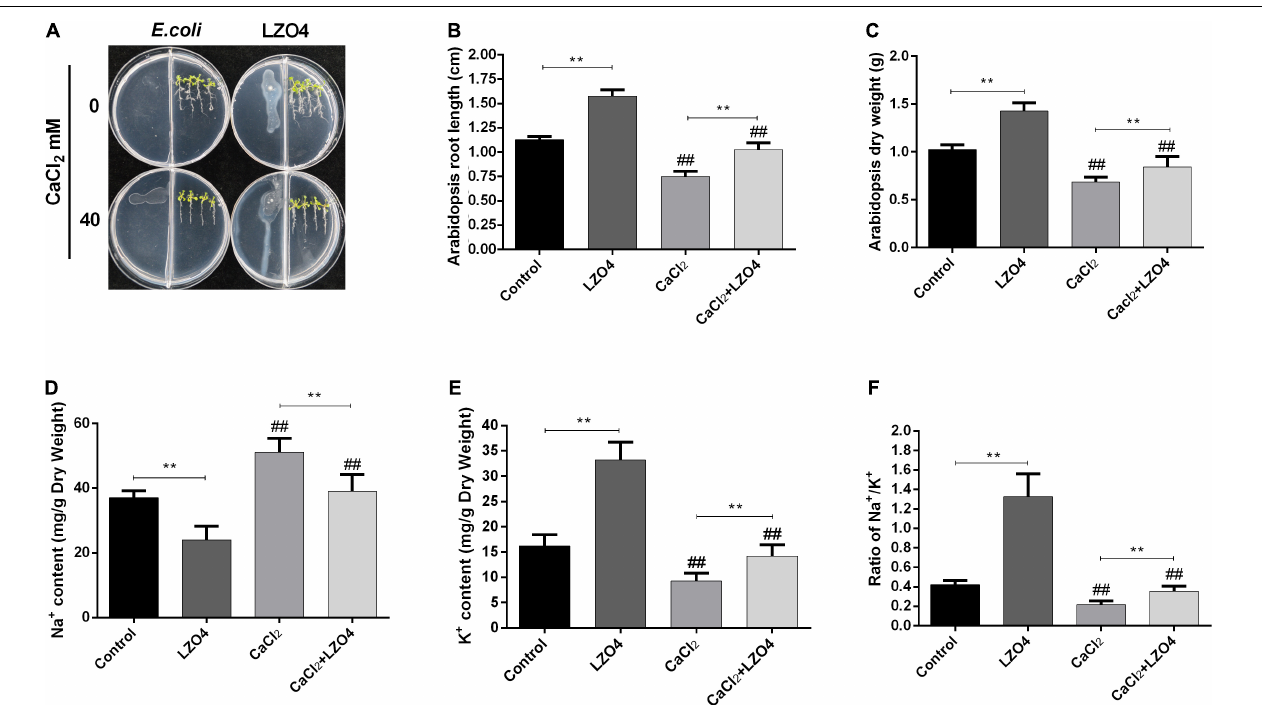
FIGURE 6 | The Adaptation of A. thaliana to high calcium stress was increased by B. amyloliquefaciens treatment. (A) Growth of A. thaliana after 48 h. (B) The length of A. thaliana roots under the four treatments conditions (48 h). (C) The dry weight of A. thaliana roots. The content of (D) Na + and (E) K + and (F) the ratio of Na + /K + in the A. thaliana roots. The mean SD ( n = 5) was used to represent the data. **indicates that significance was found ( P < 0.01) vs. control or CaCl 2 groups; ## indicates that significance was found ( P < 0.01) vs. control or LZ04